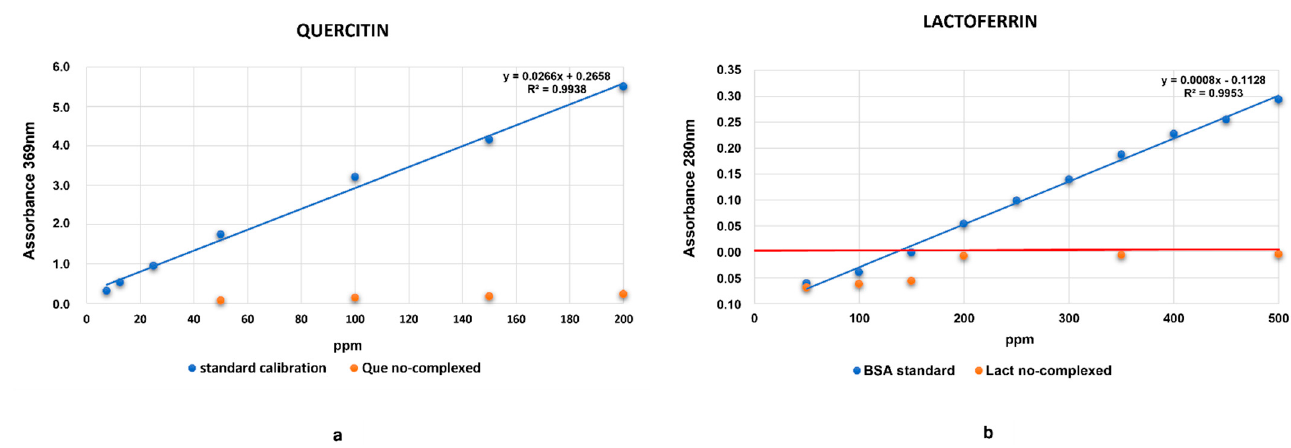
Figure 4. ( a ) The effective amount of Que (50–200 ppm) at the end of the adsorption process on HA. ( b ) The effective amount of Lacto (50–200 ppm) at the end of the adsorption process on HA.